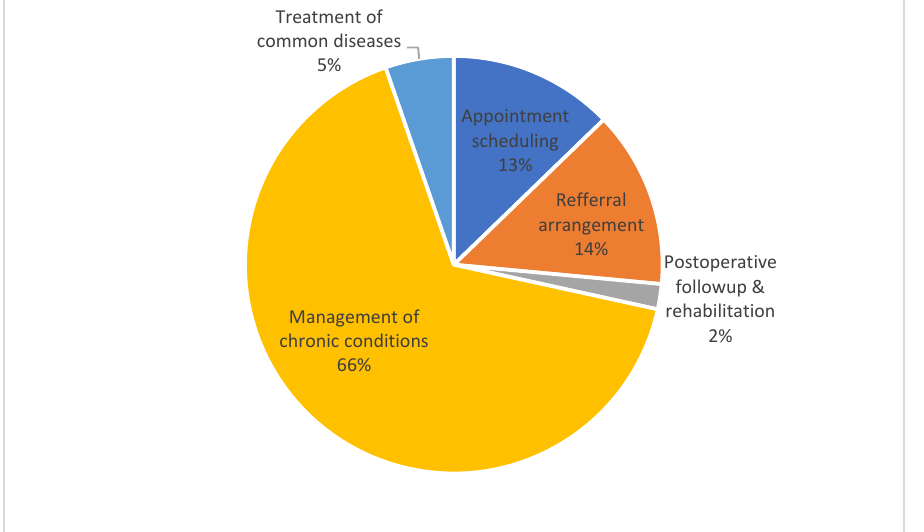
Figure 2. Preferred functional features ranked by respondents.